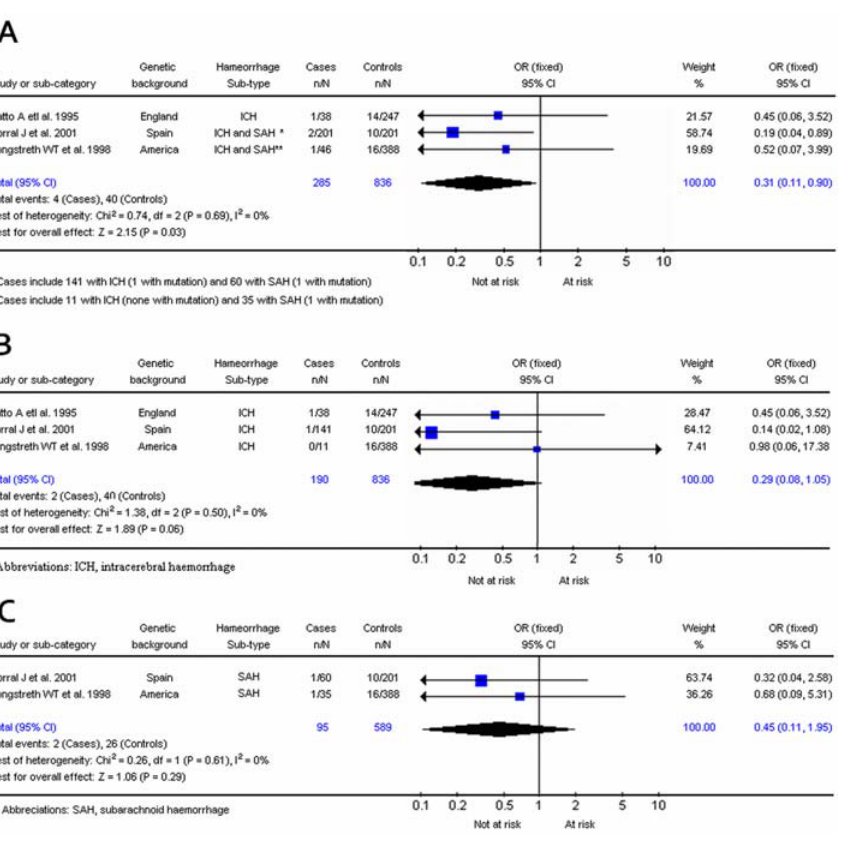
Figure 5. 5a. Results for Factor V Leiden mutation and haemorrhagic stroke. 5b. Results for Factor V Leiden mutation and ICH. 5c. Results for Factor V Leiden mutation and SAH. 0.90; p= 0.03) when compared to wild-type ( guanine/guanine ) (Figure 5a). No significant interstudy heterogeneity was observed